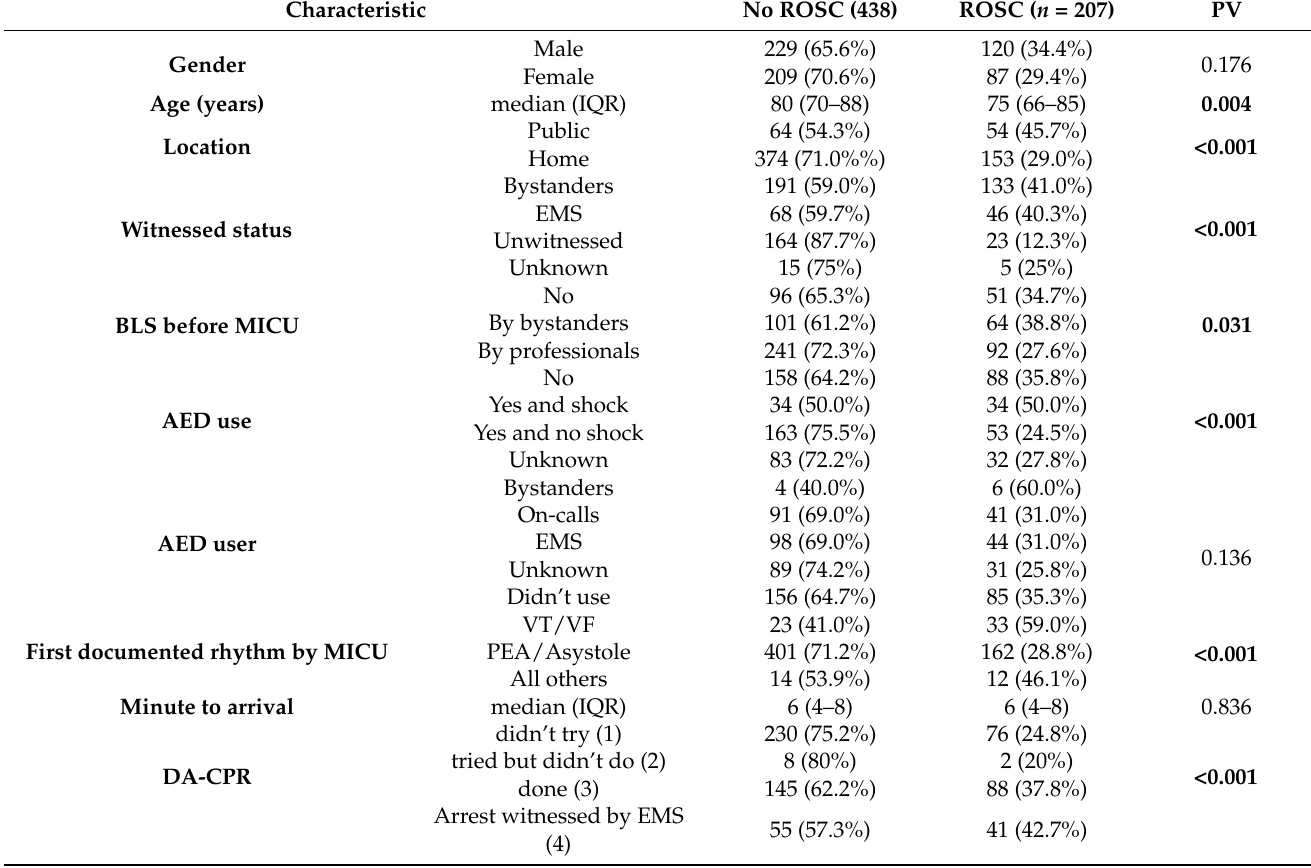
Table 1. Crude ROSC outcome according to patients’ characteristics and prehospital and hospital care.